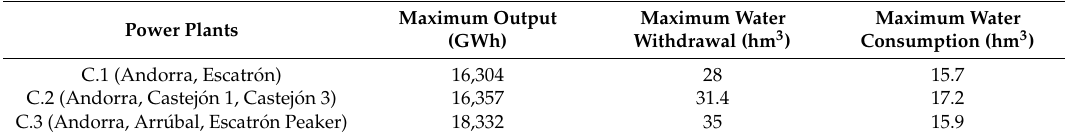
Table 5. Set of combinations from Scenario 1.